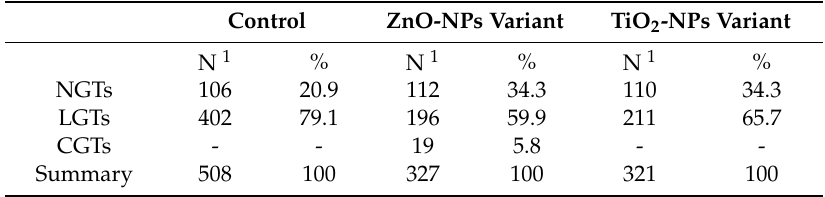
glandular trichomes).